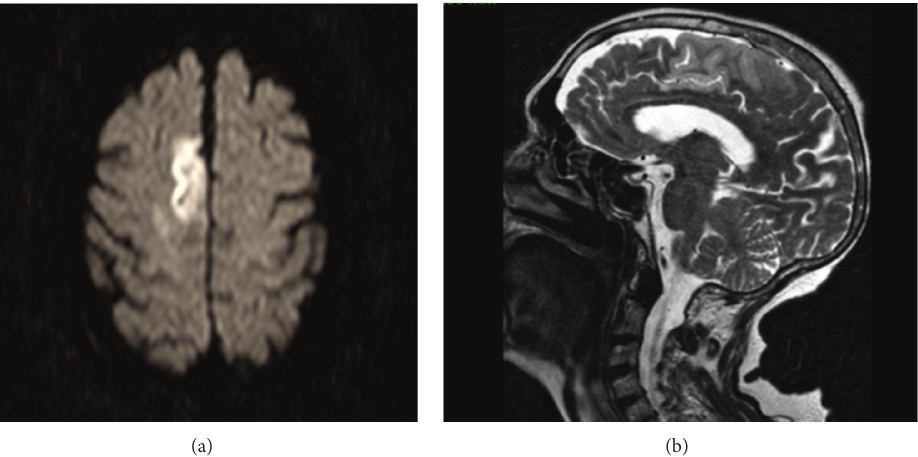
Figure 1: (a) Diffusion-weighted image and (b) T2-weighted image: right cortical and subcortical frontal parasagittal acute ischaemic lesion, affecting the superior frontal gyrus and the cingulate gyrus.